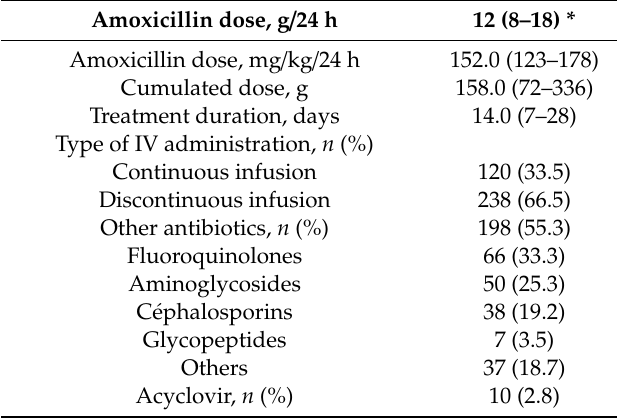
Table 2. Amoxicillin treatment and associated antibiotics. Results are presented as median (IQR) and absolute value (percentage). *